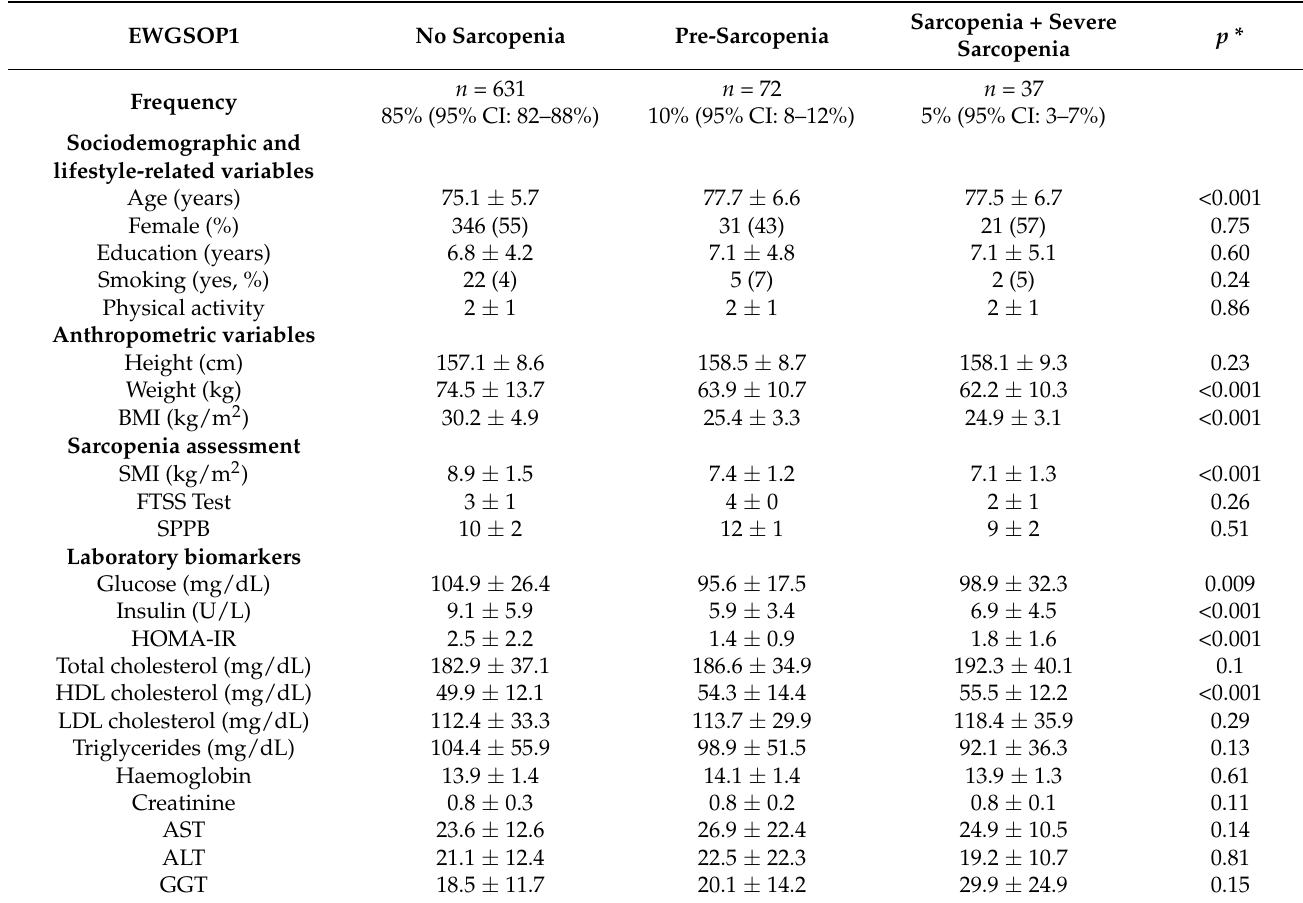
Table 3. Sociodemographic, lifestyle-related, anthropometric, sarcopenia-related, and laboratory biomarker characteristics of the study participants according to the different sarcopenia-related categories, European Working Group on Sarcopenia in Older People 2010, EWGSOP1. The Salus in Apulia Study ( n =